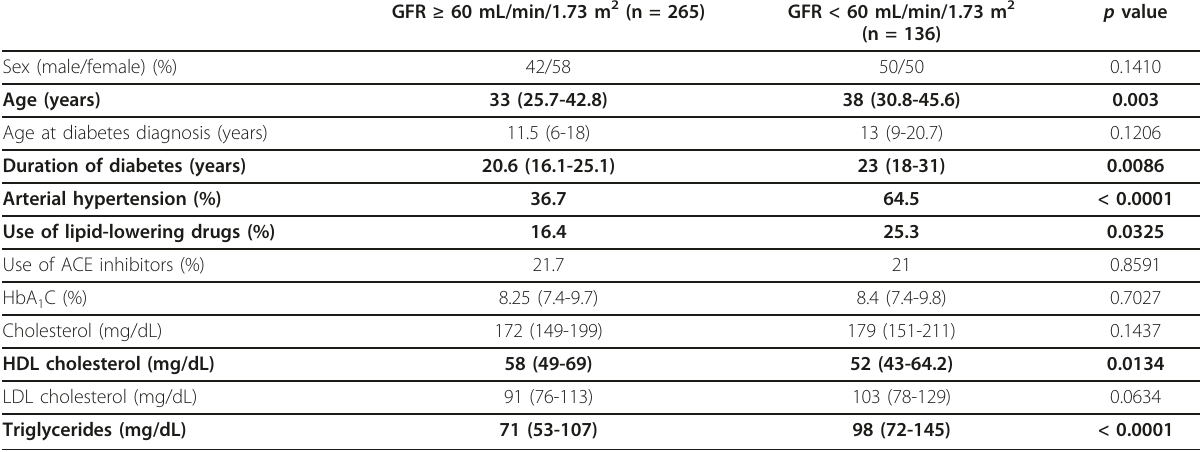
Table 2 Characteristics of type 1 diabetes patients according to the Glomerular Filtration Rate (GFR) status